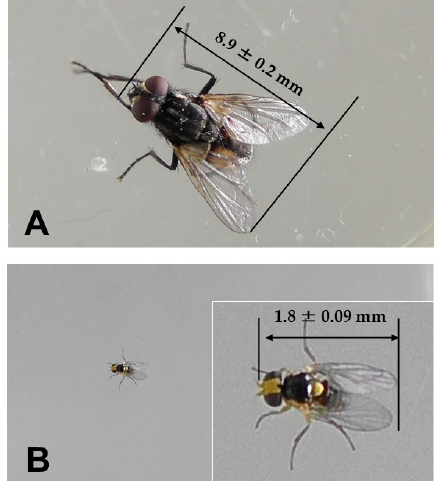
Figure 5. Comparative demonstration with test flies of different body sizes: housefly ( A ) and tomato leaf miner ( B ). The inserted photograph in ( B ) is an enlarged image of the fly.